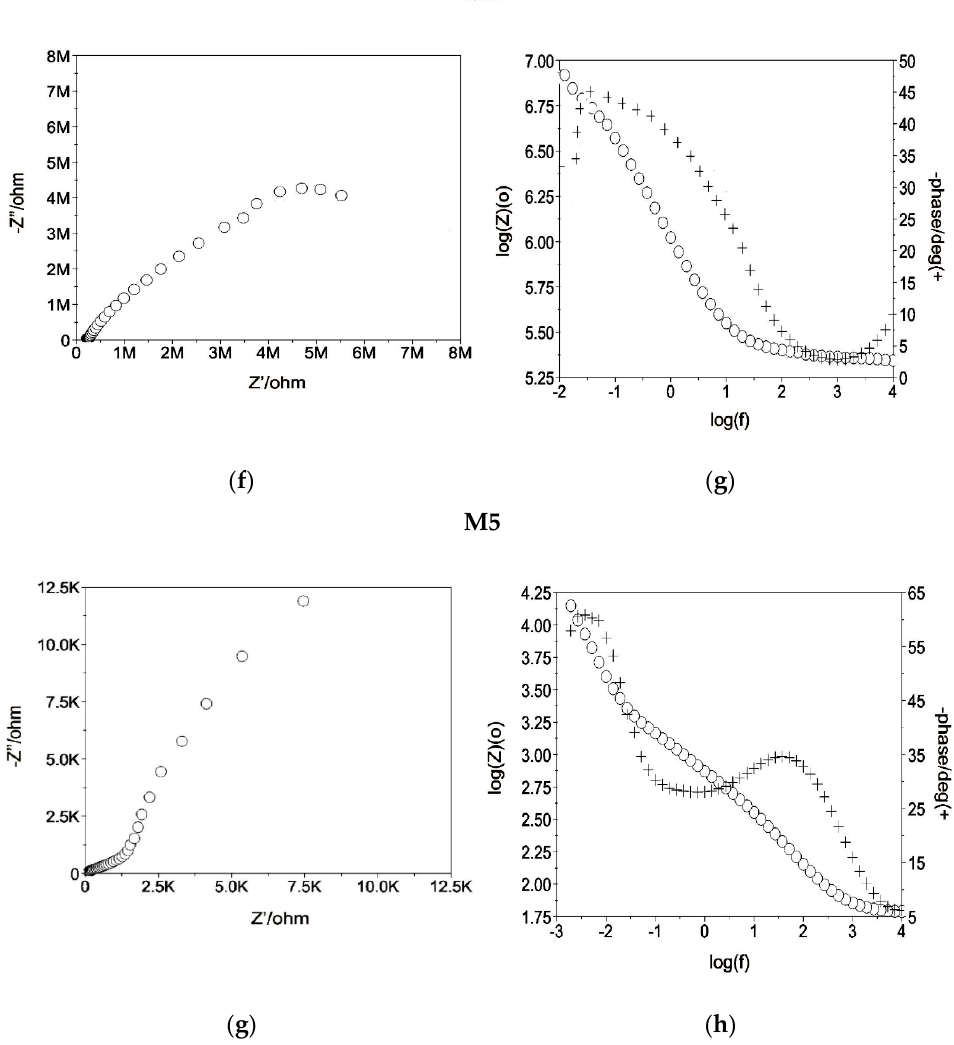
Figure 9. Examples of results of electrochemical impedance spectroscopy (EIS) test for M1 ( a ); ( c ); ( e ); ( g ) Nyquist diagram; ( b ); ( d ); ( f ); ( h ) Bode diagram.